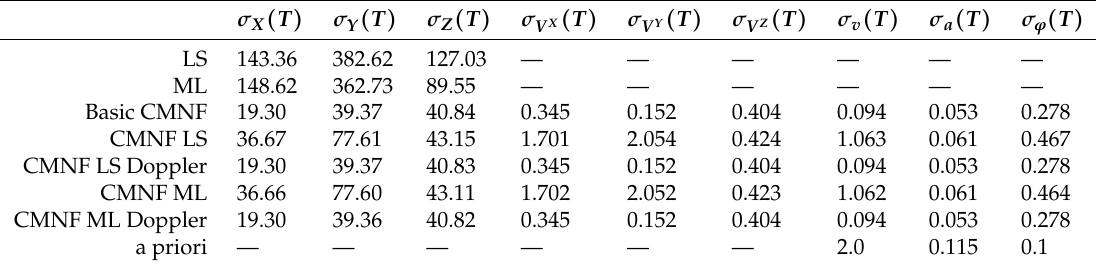
Table 2. Parameter-wise standard deviation of estimation error σ F ( T ) for F ∈ {LS, ML, Basic